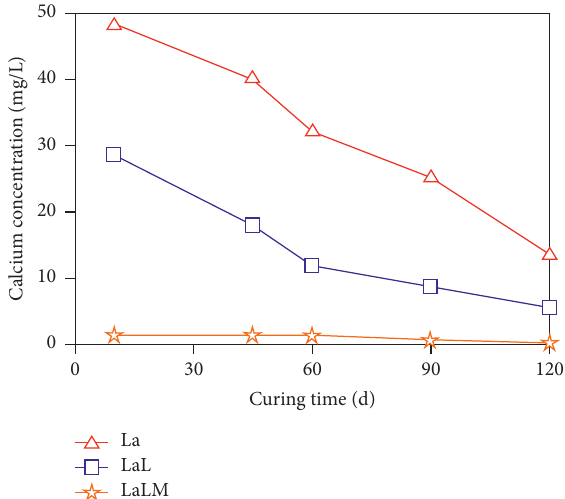
Figure 12: Calcium concentration as a function of curing time.